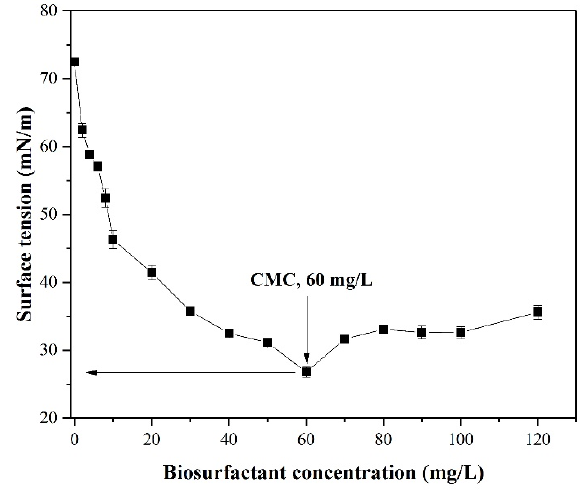
Figure 5. Surface tension versus concentration of isolated biosurfactant produced by Planococcus sp. XW-1.